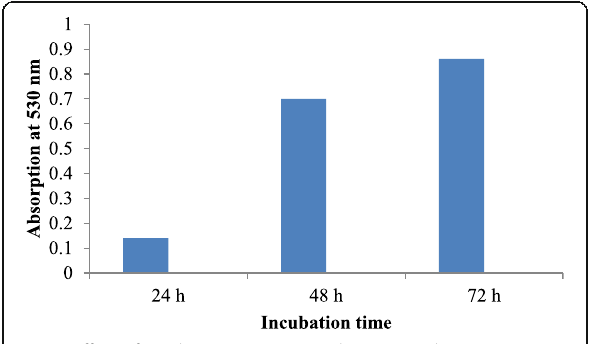
Fig. 3 Effect of incubation time on prodigiosin